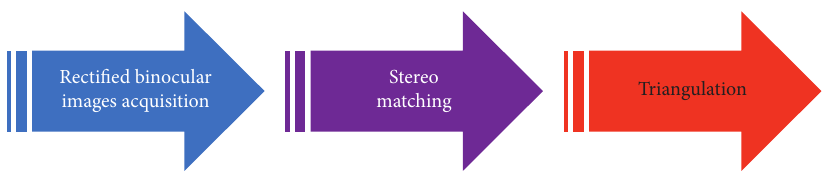
Figure 4: Flow chart of point cloud